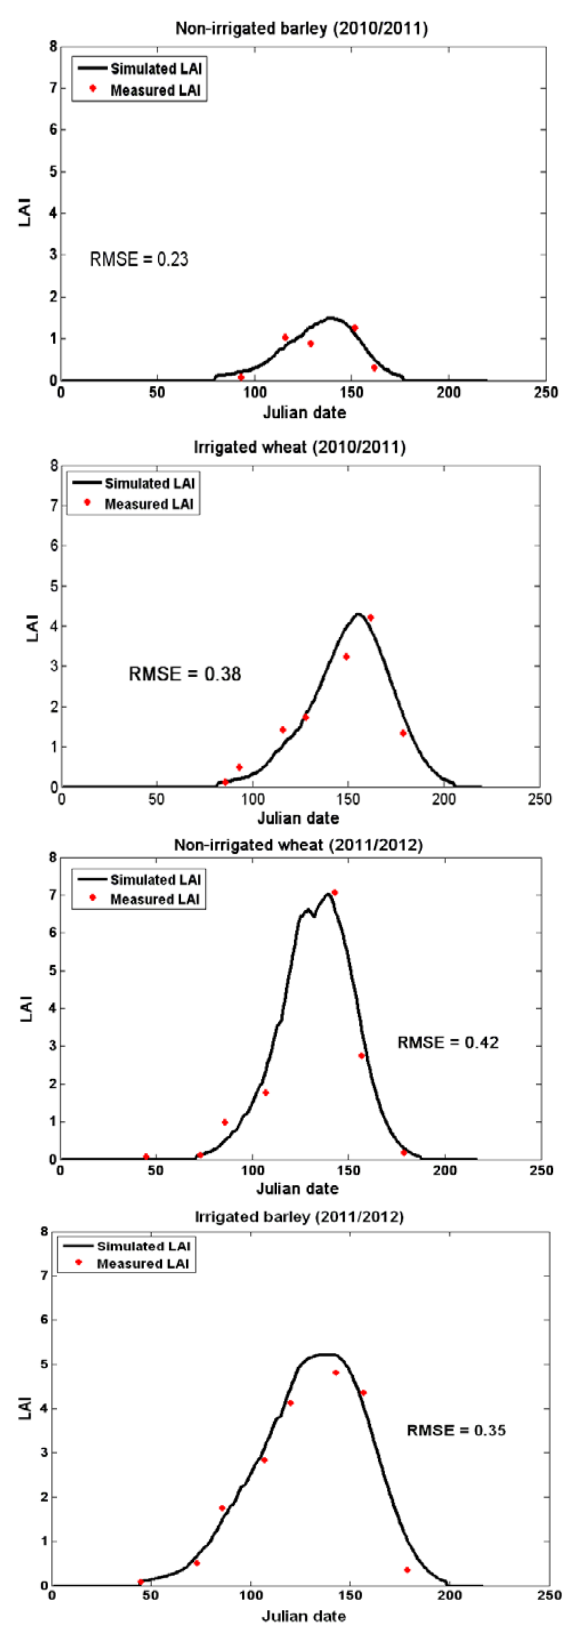
Figure 6. Values of observed (star) and simulated (line) LAI, estimated using the SAFY model for four test plots on the Kairouan plain during both agricultural seasons (1st Julian date = 1 November).